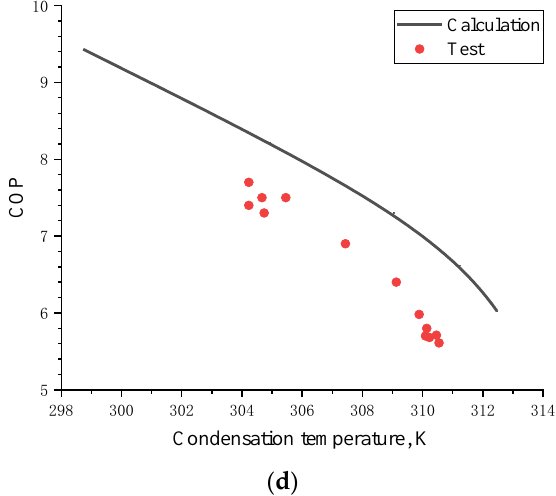
Figure 11. Verification of calculated and experimental: ( a ) Mass flow rate-pressure ratio performance curve; ( b ) Mass flow rate-power performance curve; ( c ) Cooling capacity at different condensation temperatures; ( d ) COP at different condensation temperatures.